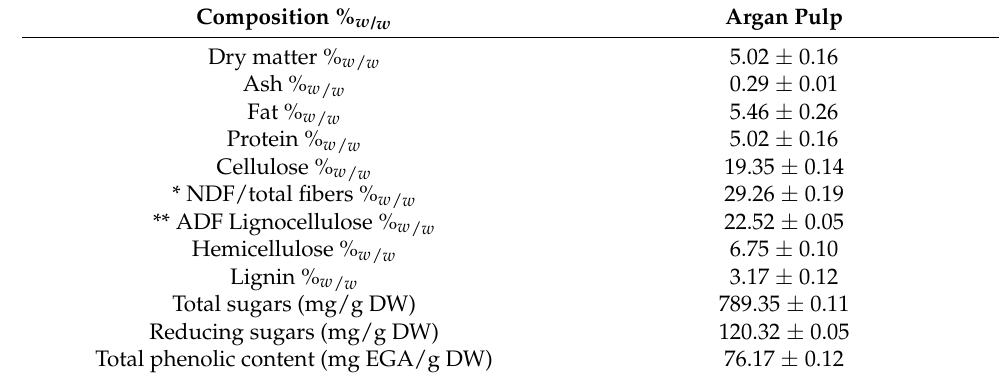
Table 1. Content of main chemical constituents of argan pulp values corresponded to mean ± SD (standard deviation) of measurements performed in